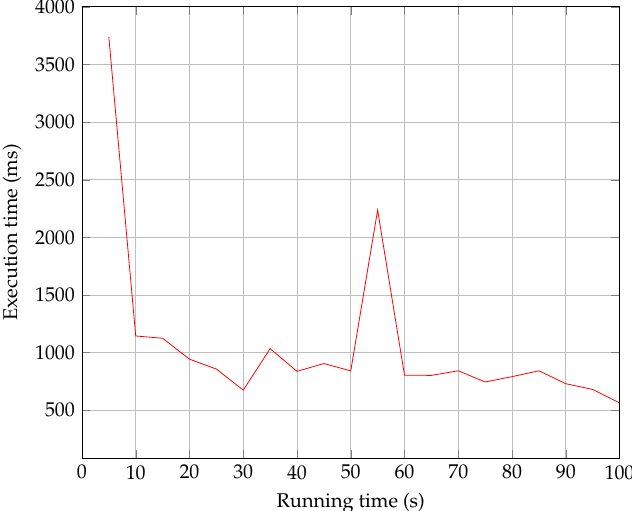
Figure 4. Computed inferring time for the Java tool.